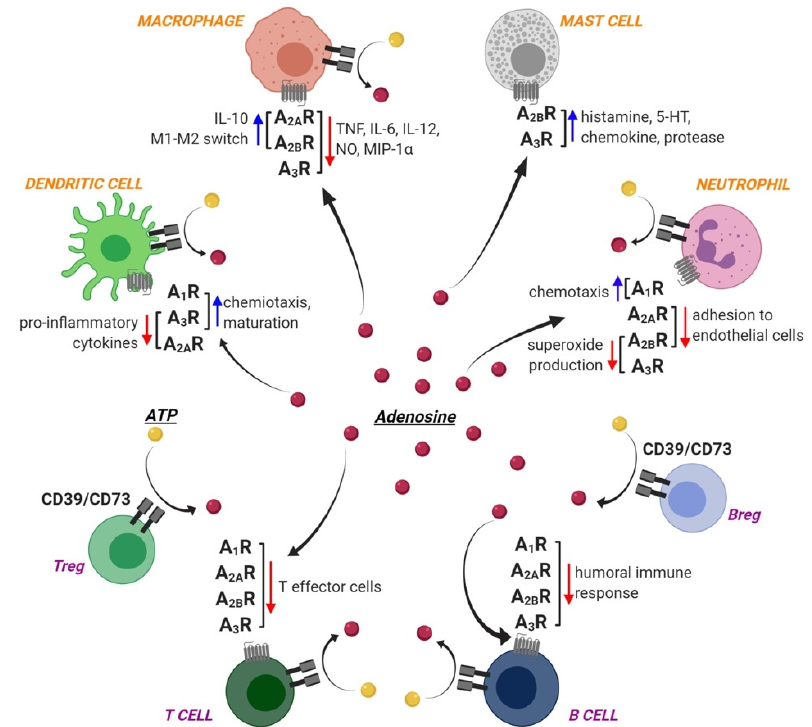
Figure 1. Schematic representation of Ado receptor expression and functions on innate immunity (orange text) and acquired immunity (purple text) cells. Red and blue arrows represent functions that are reduced and enhanced, respectively, by Ado binding to the di ff erent receptor subtypes. ATP-metabolizing enzymes CD73 and CD39 are also shown, which cooperate in the generation of extracellular Ado (red dots) through ATP (yellow dots) hydrolysis, thus shifting the balance towards an immunosuppressive environment. Both CD39 and CD73 are highly expressed by T regs and B regs , which act as functional regulators for anti-inflammatory and immunosuppressive action during inflammation / infection. See text for details. Created with BioRender.com.